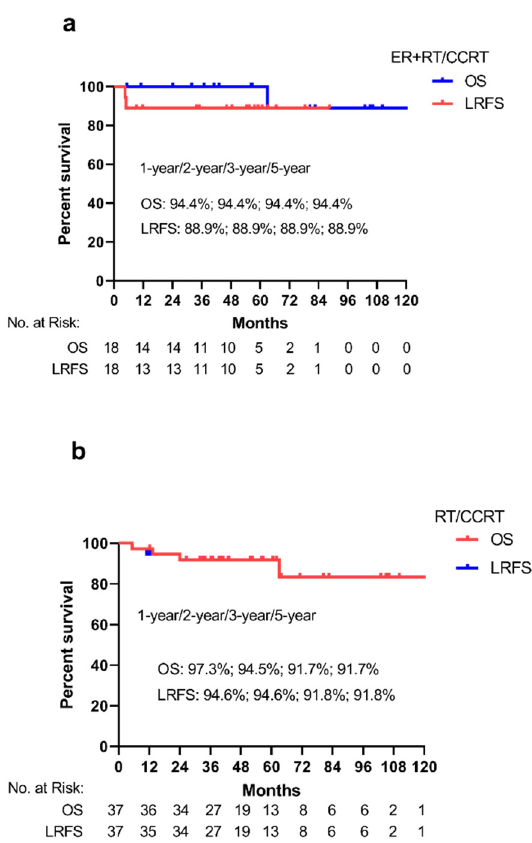
Figure 2. Kaplan–Meier analysis of local recurrence-free survival (LRFS) and overall survival (OS) in two groups: ER + RT/CCRT group ( a ); RT/CCRT group ( b ). The percent survival of 1-, 2-, 3- and 5-year of LRFS and OS rate and the number at risk are also presented.